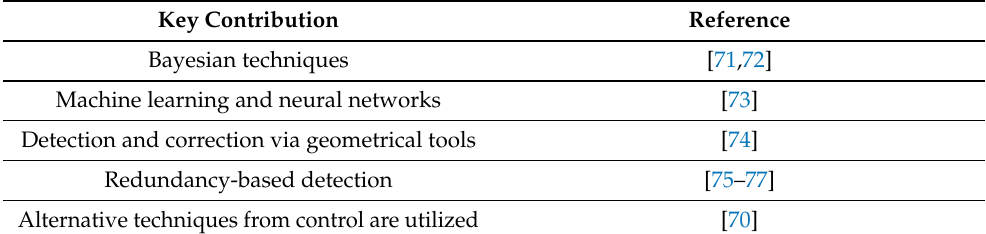
Table 4. Summary of